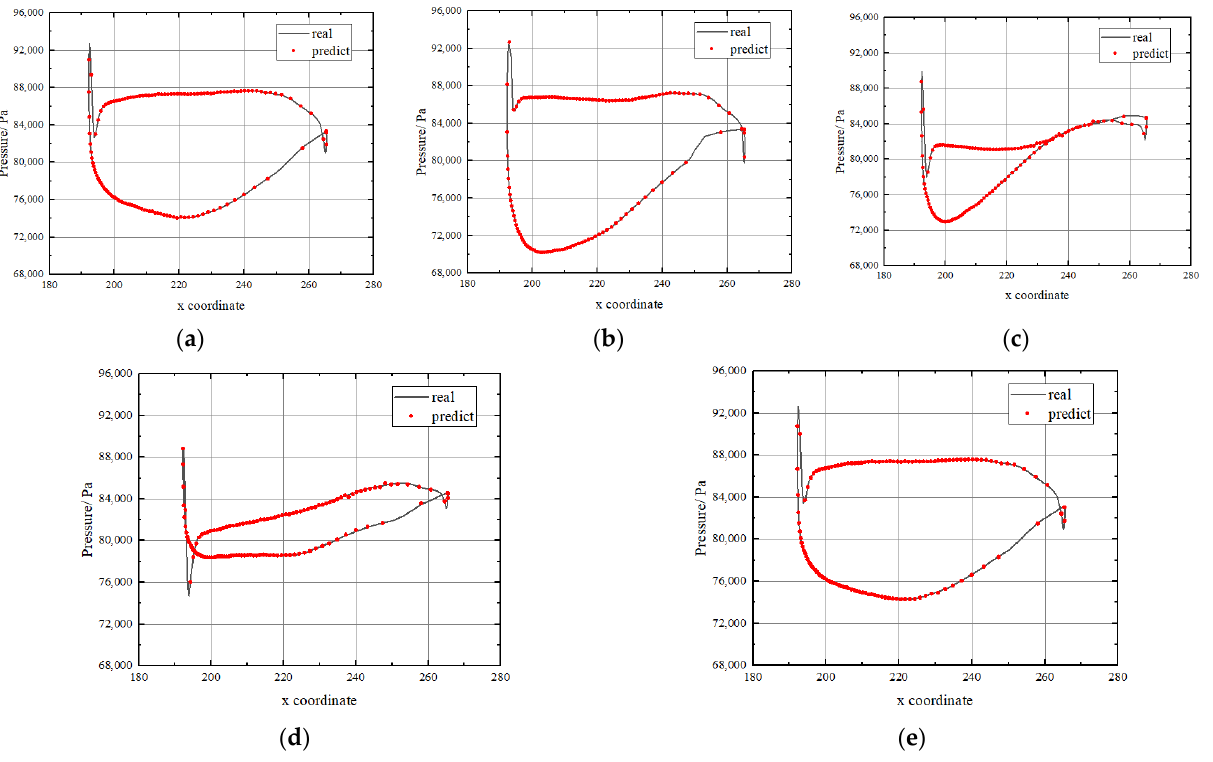
Figure 11. Unsteady pressure on stator surface at 90% span. ( a ) t = 0. ( b ) t = 1/4T. ( c ) t = 1/2T. ( d ) t = 3/4T. ( e ) t = T.